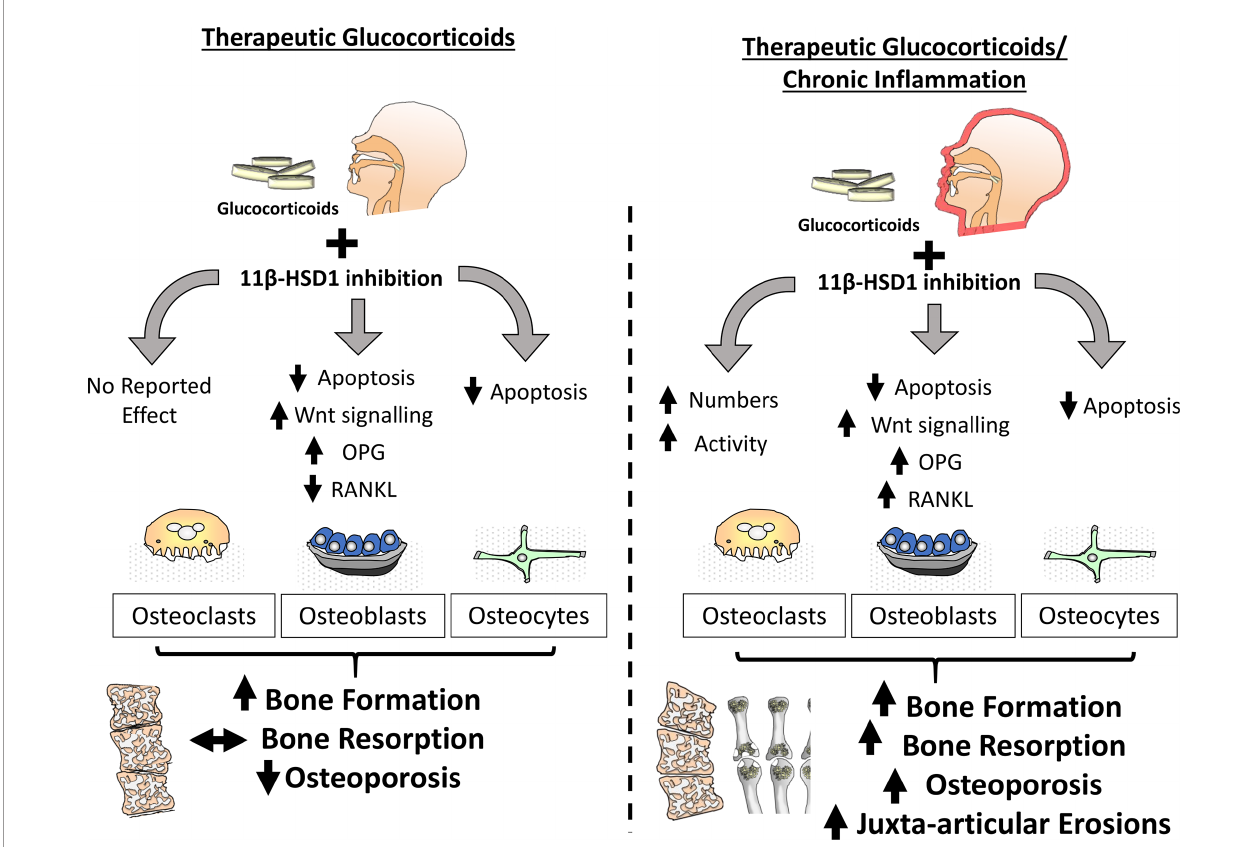
FIGURE 3 | In the absence of in fl ammation within bone, inhibition of 11 b -HSD1 protects against the actions of exogenous glucocorticoids in both osteoblasts and osteoclasts. The effect of these inhibitors is characterised by a protection from glucocorticoid induced apoptosis in both osteoblasts and osteocytes, preventing a glucocorticoid suppression of bone formation. During chronic in fl ammatory diseases such as rheumatoid arthritis, the protective actions of 11 b -HSD1 inhibition in response to exogenous therapeutic glucocorticoids in osteoblasts and osteocytes remains evident but is overshadowed by a resistance to the anti-in fl ammatory properties of exogenous glucocorticoids that results in aberrant osteoclast numbers and activation. Consequently, 11 b -HSD1 inhibition results in rapid bone resorption and exacerbation of both local and systemic in fl ammatory bone